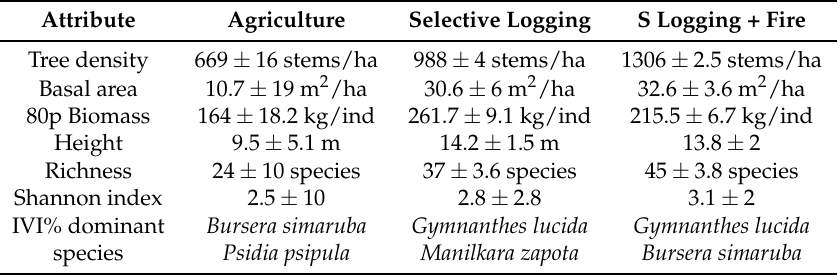
Table 1. Vegetation patches characterization by disturbance